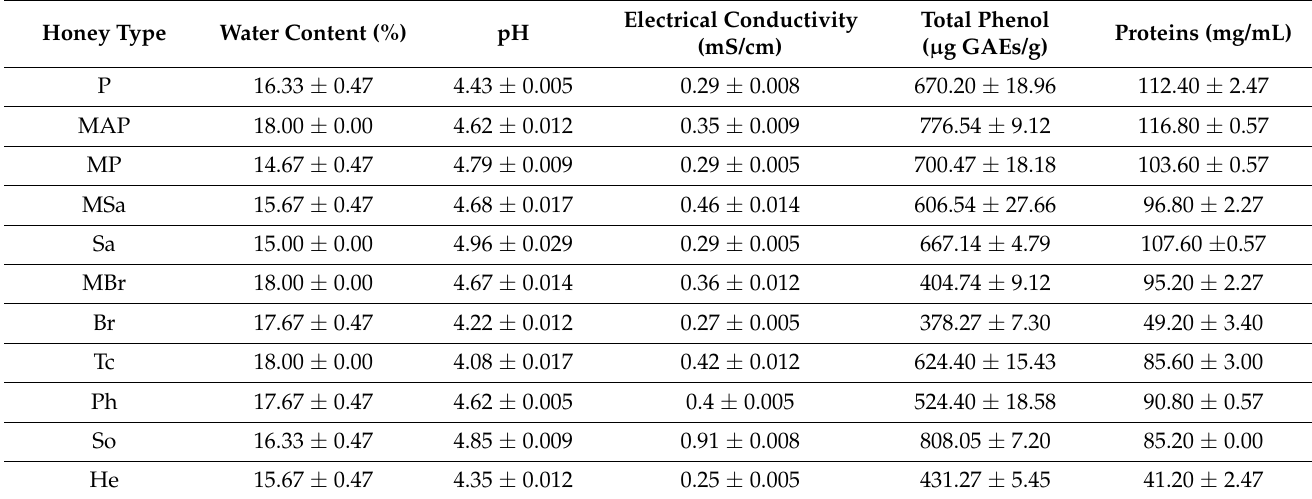
Table 1. Physicochemical characteristics of tested honey types, average ± SD, N =